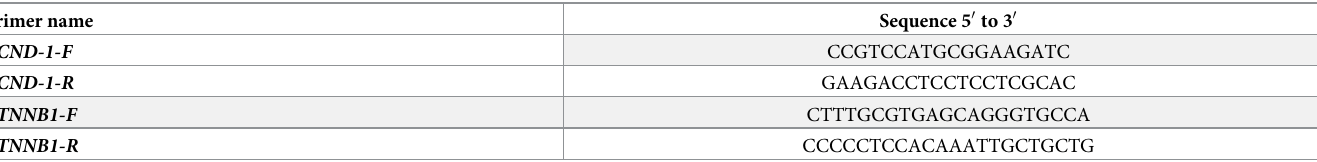
Table 2. Sequence of